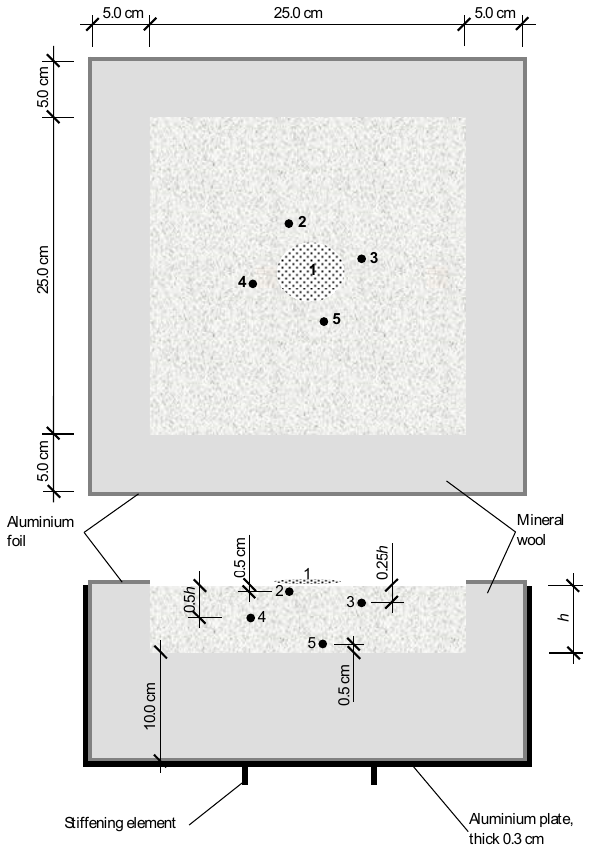
Figure 8. Schematic of HMA specimen prepared for temperature drop testing showing measurement locations.